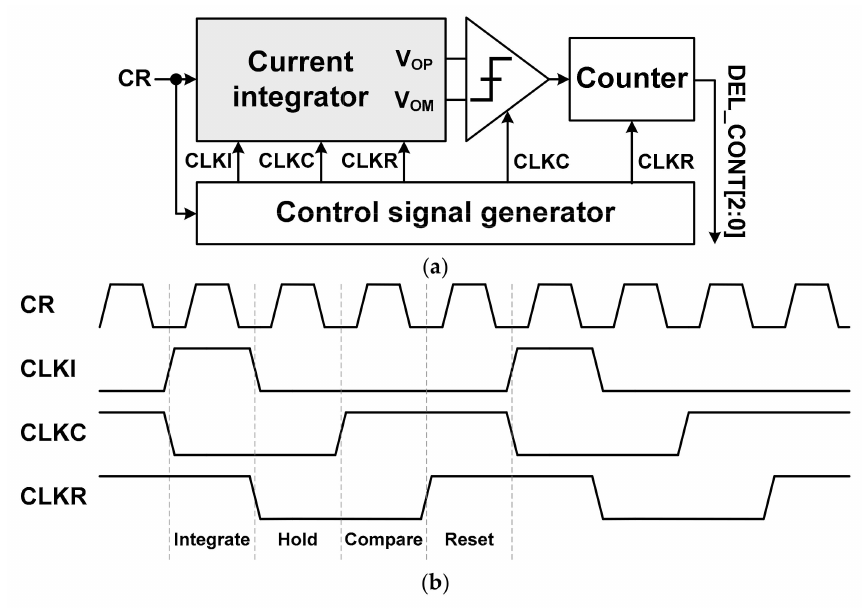
Figure 9. Data-dependent time jitter corrector: ( a ) Block diagram; ( b ) Time